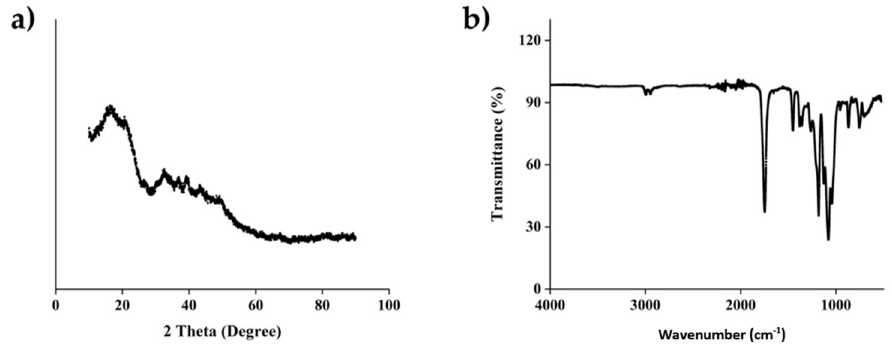
Figure 5. ( a ) The crystalline phase and molecular interaction and ( b ) Fourier Transform infrared wave spectrum of PLA.